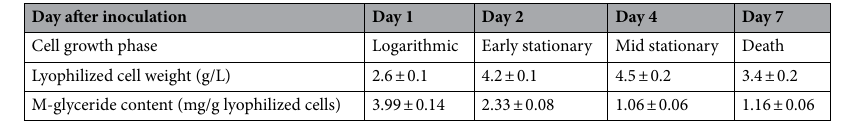
Table 5. Changes in M-glyceride contents in cells of Aurantiochytrium sp. SYLR6#3 during culture. Biomass was expressed as g/L of lyophilized cells with ± SD (n = 4). M-glyceride contents were expressed as mg/g of lyophilized cells with ± SD (n = 4). M-glyceride content was determined by HPLC with PDA detector (205 nm) and Wakosil 5NH2 (2.0 × 150 mm) column.